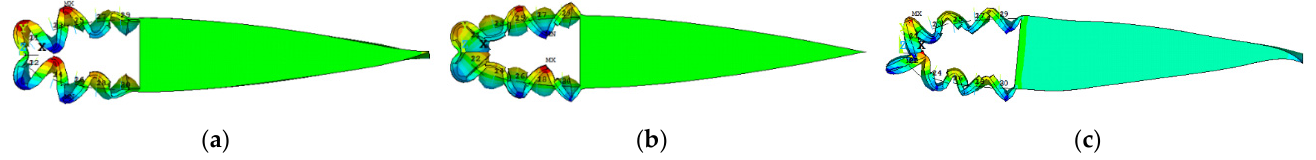
Figure 6. Vibration modes of the leading edge with the PZT patches. ( a ) The 51st vibration mode (21,935.6 Hz); ( b ) The 61st vibration mode (25,094 Hz); ( c ) The 68th vibration mode (27,896.9 Hz).